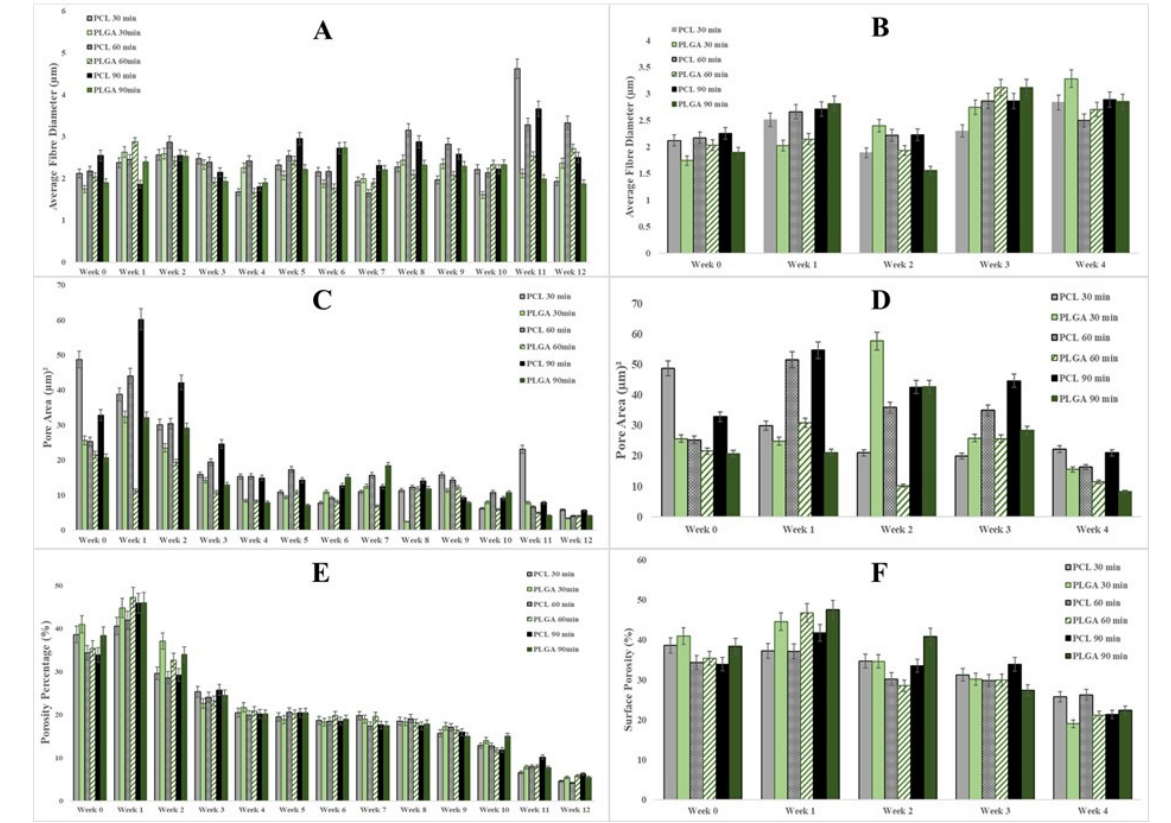
Figure 6. ( A ) Average fibre diameter change (µm) of electrospun scaffolds over a degradation period of 12 weeks at room temperature; ( B ) Average fibre diameter change (µm) of electrospun PCL and PLGA scaffolds over a degradation period of 4 weeks and under temperature-controlled conditions (37 °C); ( C ) Changes in surface pore size (µm)² of electrospun PCL and PLGA scaffolds over a 12-week degradation period at room temperature; ( D ) Changes in surface pore size (µm)² of electrospun PCL and PLGA scaffolds over a 4-week degradation period under temperature-controlled conditions (37 °C); ( E ) Changes in surface porosity percentages of electrospun PCL and PLGA scaffolds over a degradation period of 12 weeks at room temperature; ( F ) Changes in surface porosity percentages of electrospun PCL and PLGA scaffolds over a degradation period of 4 weeks under temperature-controlled conditions (37 °C). Table 3. (A) Percentage change in fibre dimeter of PCL and PLGA scaffolds at week 12 of degradation compared to week 0, (B) Percentage change in pore size for PCL and PLGA scaffolds electrospun for 30, 60, and 90 minutes, (C) Percentage change in surface porosity percentage for PCL and PLGA scaffolds electrospun for 30, 60, and 90 minutes. (-) = decrease and (+) = increase.